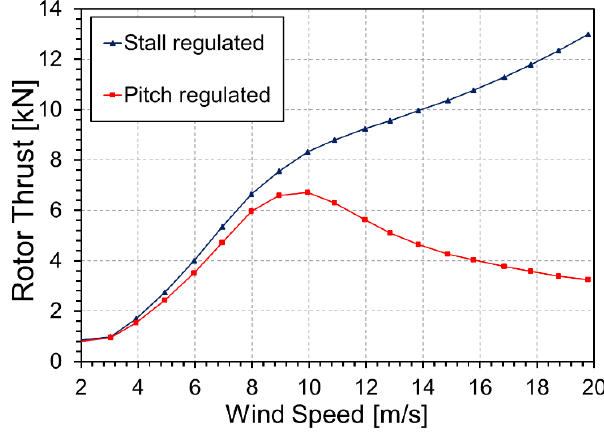
Figure 13. Average rotor thrust curves in dynamic conditions.